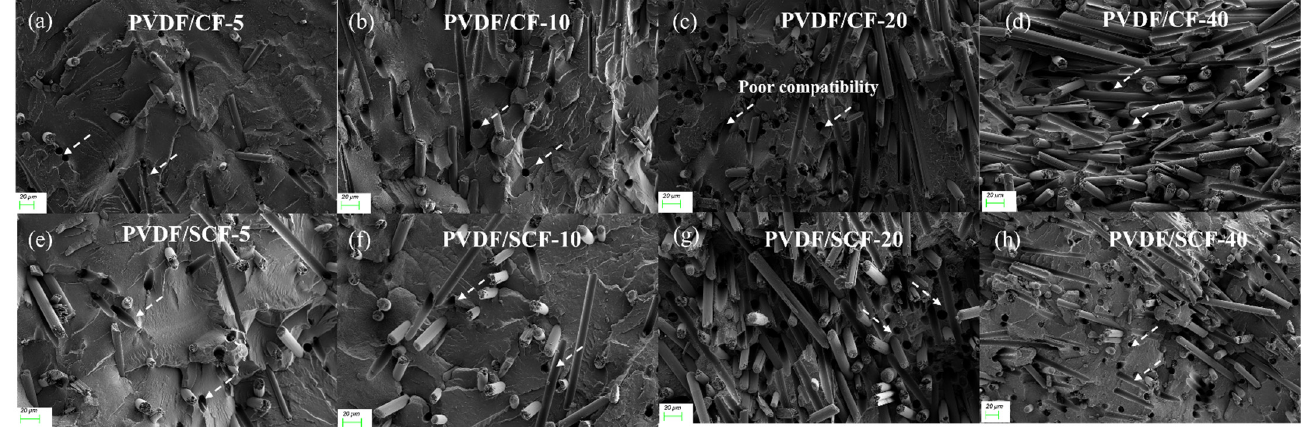
Figure 3. SEM images of the PVDF composites: ( a – d ) PVDF/CF; and ( e – h ) PVDF/SCF composite series. (Scale bar in each image: 20 µm)